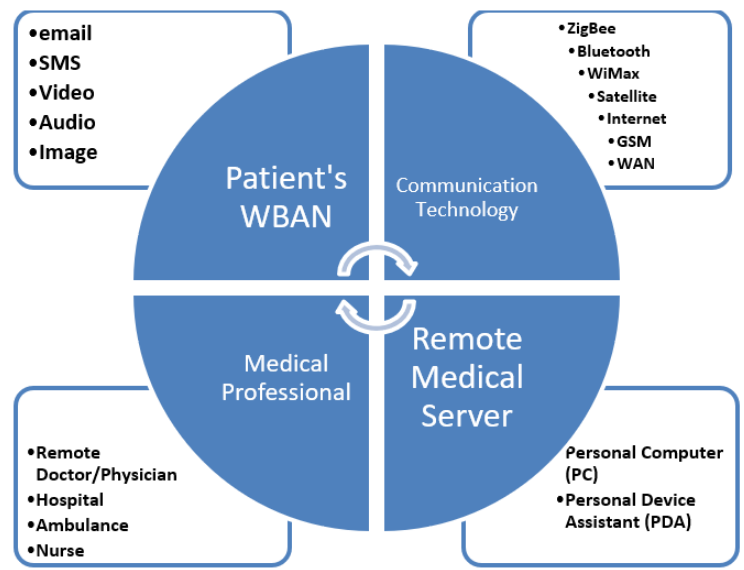
Figure 3. Components of a Telemedicine